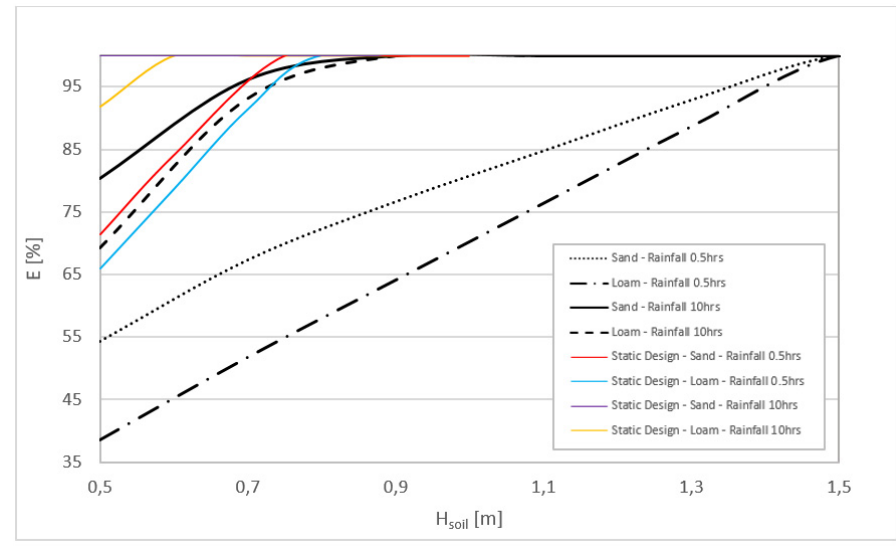
Figure 6. Efficiency as a function of trench’s depth for sandy and loamy surrounding soils after two rain events with same rain volume and different duration (low and high intensity of rainfall).